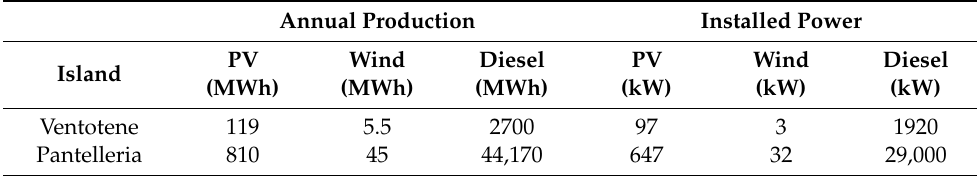
Table 3. Actual energy mix of the